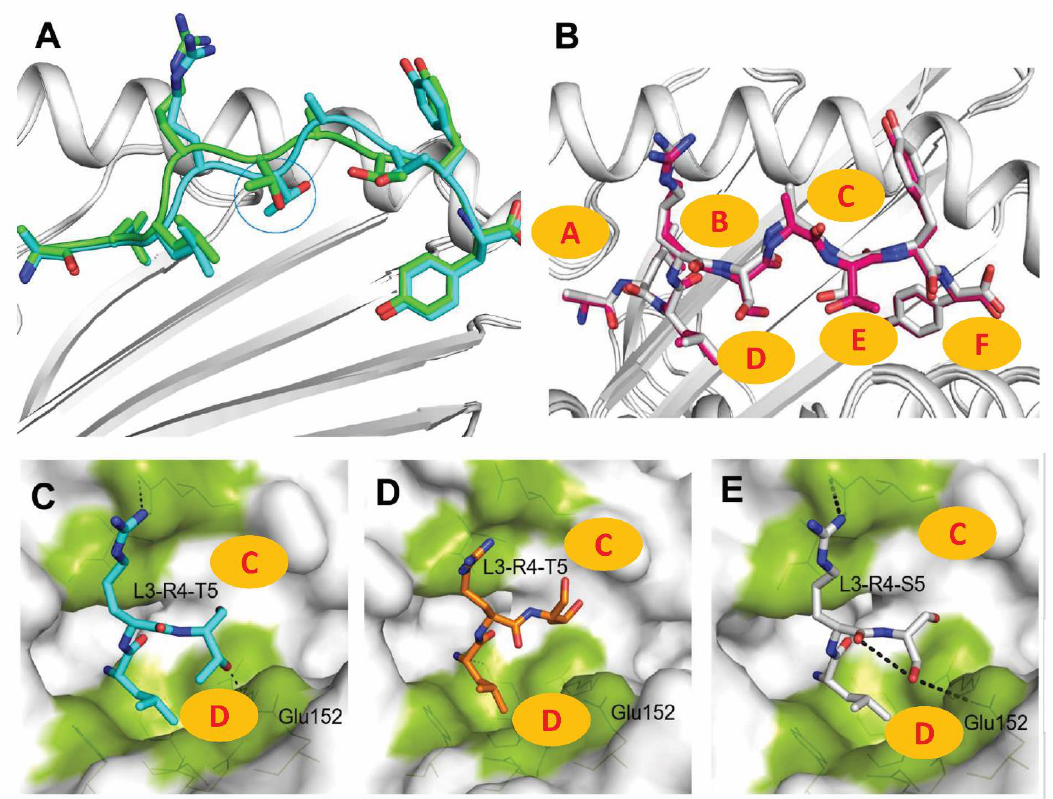
Figure 2. Analysis and comparison of the two conformations of the crystals of SLA-2*HB01–Hu64– s β 2 m and SLA–2*HB01–As64–s β 2 m. The two conformations of the crystals of ( A ) SLA-2*HB01– Hu64–s β 2 m and ( B ) SLA-2*HB01–As64–s β 2 m. The marine circle in ( A ) represents P5 of the two Hu64 refolded conformations. The refolding state of peptide Hu64 in the peptide-binding groove of SLA-2*HB01–Hu64–s β 2 m in ( C ) crystal conformation 1 (CM1) and ( D ) crystal conformation 2 (CM2). ( E ) The refolding state of peptide As64 in the peptide-binding groove of the SLA-2*HB01–As64–s β 2 m crystal. Areas marked A–F in highlighted brown indicate the different pockets in the peptide-binding groove. The dotted lines in ( C , E ) indicate the key hydrogen bonds between atoms of the peptides and atoms of the main chain